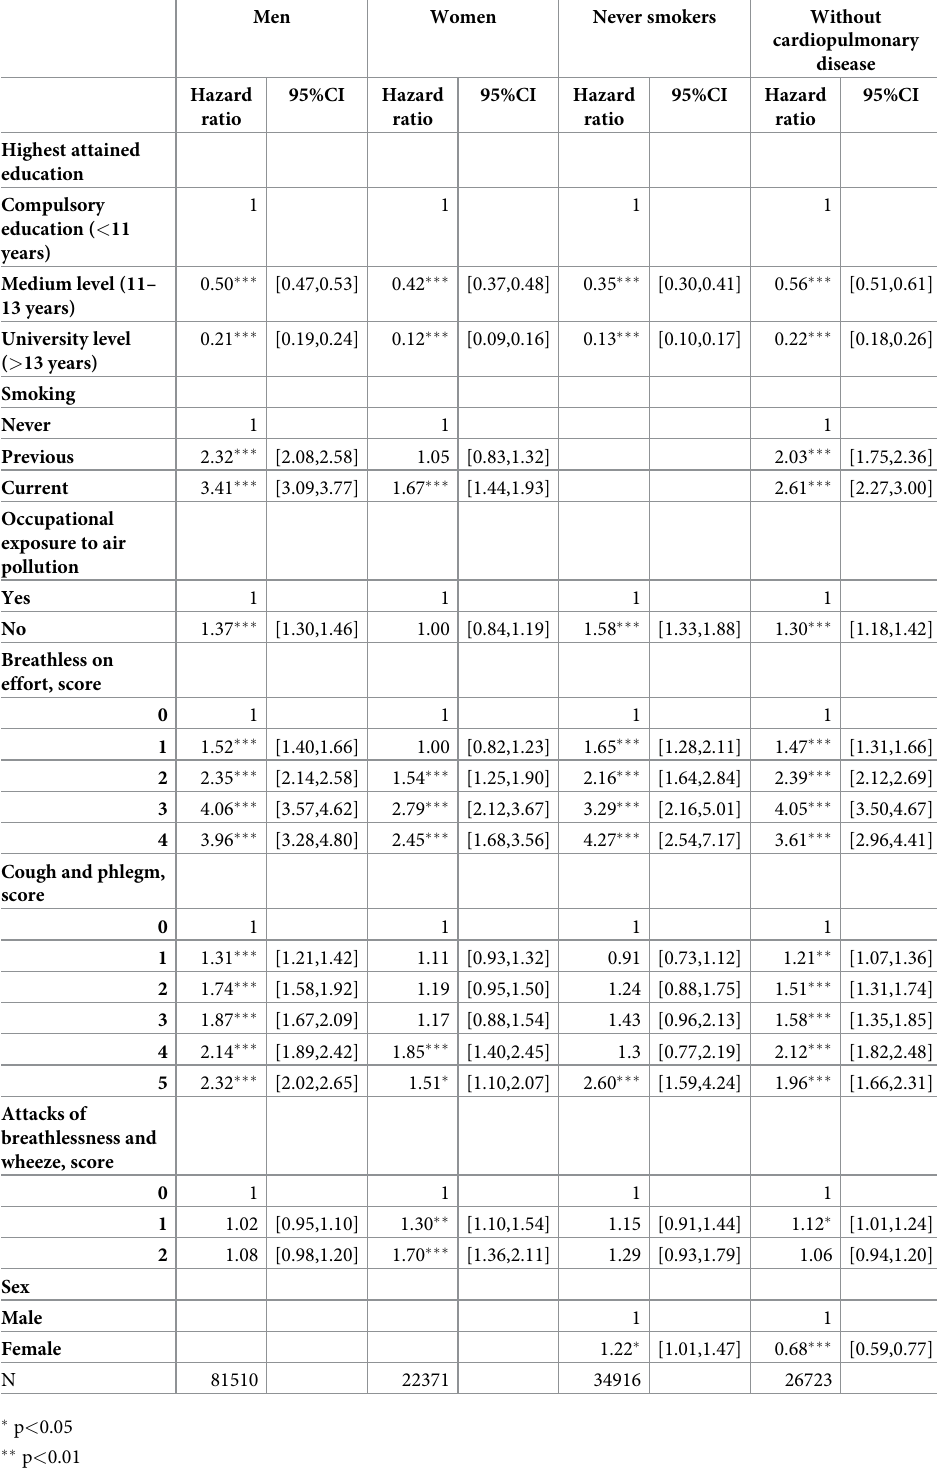
Table 5. Hazard ratios for death with 95% confidence intervals and p-values, all pulmonary causes of death, in subgroups of the total population. Multivariable proportional hazards regression